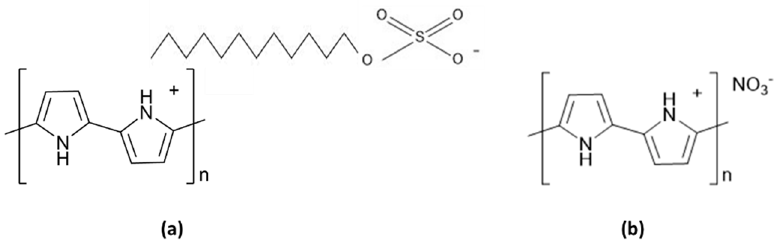
Figure 1. Schematic of polypyrrole (PPy) in the oxidised form with different counterions ( a ) dodecylsulfate; ( b )